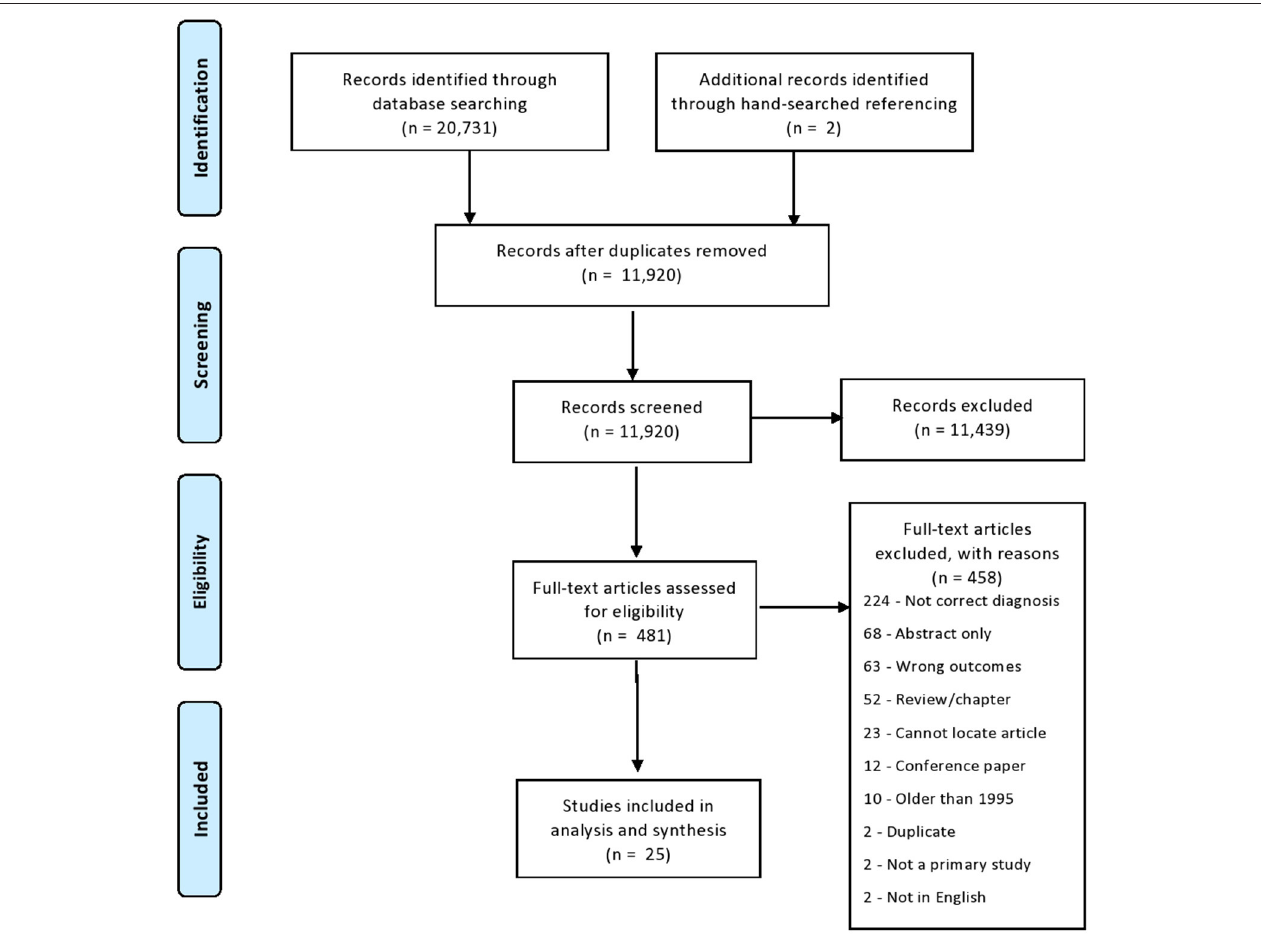
FIGURE 1 | PRISMA flow